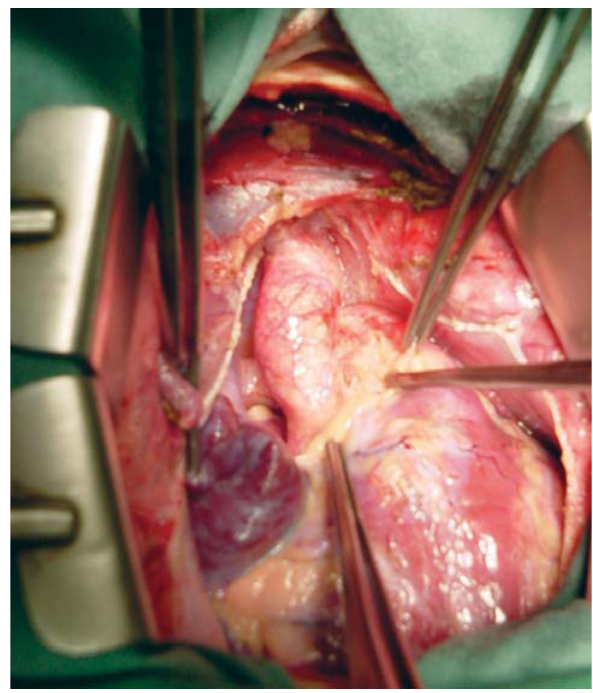
Fig. 1 - Aspecto anatômico da estenose aórtica